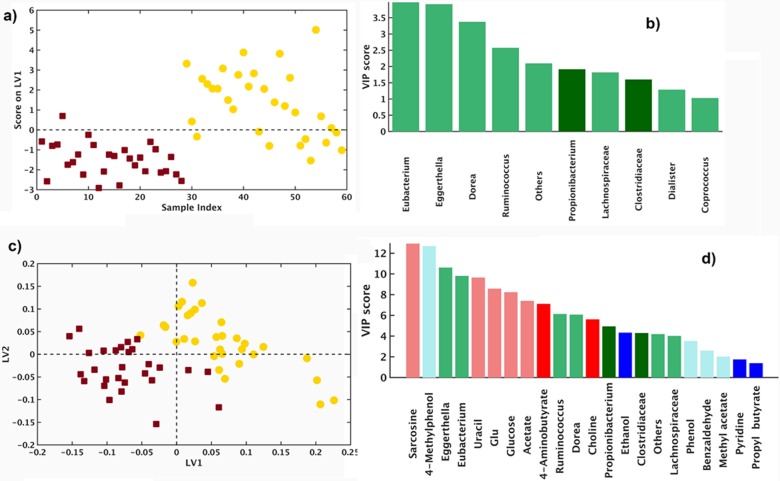
PLS-DA results.OTU (genus level) reduced analysis. Panel A. LV scores plot: yellow, HC; dark red, CF. Panel B. histograms representing VIP values: pale green, low levels; dark green, high levels in CF. Panel C. Low data fused: OTUs (genus level), GC-MS/SPME, and 1H-NMR analysis. LVs score plot: yellow, HC; dark red, CF. Panel D. histograms representing VIP values: pale blue, pale red, pale green, low levels; dark blue, dark red, dark green, high levels in CF.